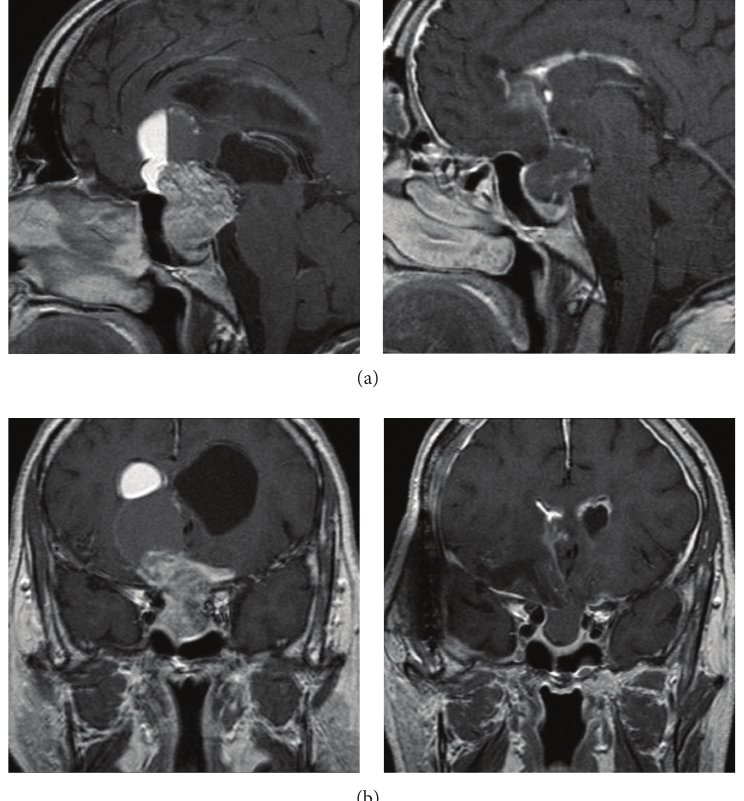
Figure 1: Sagittal T1 with contrast MRIs (a) and coronal T1 with contrast MRIs (b) showing a large sellar mass with significant suprasellar